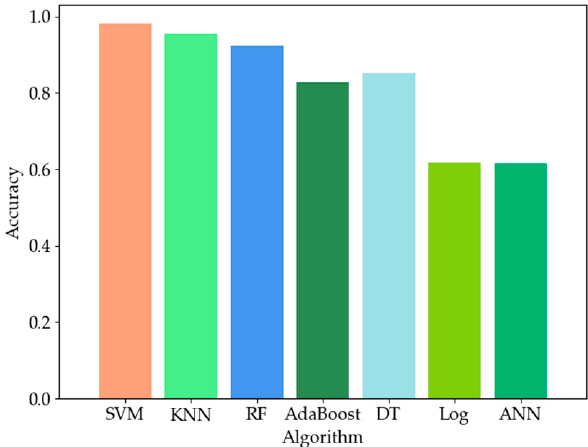
( b ) Figure 7. The effects of K-fold method. ( a ) Comparation between SVM with other methods. ( b ) K- fold of SVM. Figure 8 shows the accuracy of seven classifier models. Table 4 gives the seven clas- sifiers’ accuracy, recall, precision and F 1 -scores. Figure 8 and Table 4 show that the SVM achieves the highest classification accuracy and recall rate. SVM, KNN, RF and ANN have higher precision among the seven models, and SVM has the highest F 1 -score. Table 4. Performance evaluation of seven classifier models. Accuracy